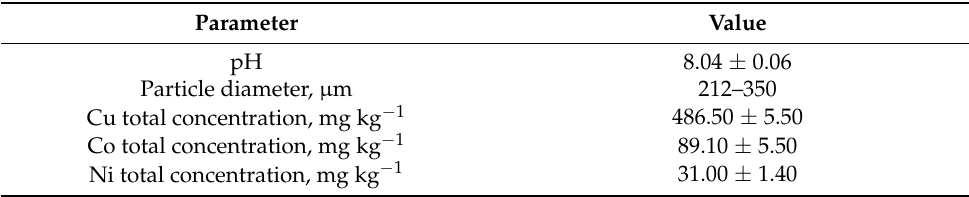
Table 1. Sample metal content, pH, and particle